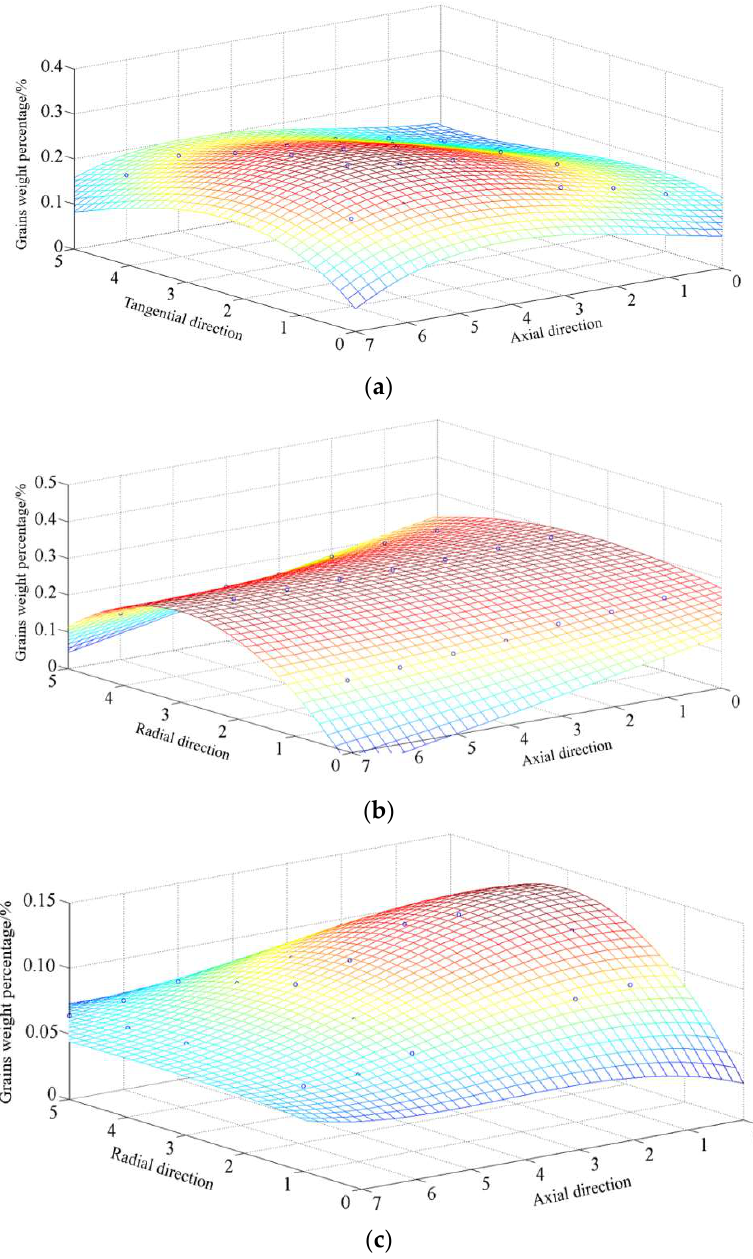
Figure 11. Threshing flow distribution variation law quadratic response surface. ( a ) Tangential flow threshing zone A; ( b ) transverse axial flow threshing zone B; ( c ) transverse axial flow threshing zone C.